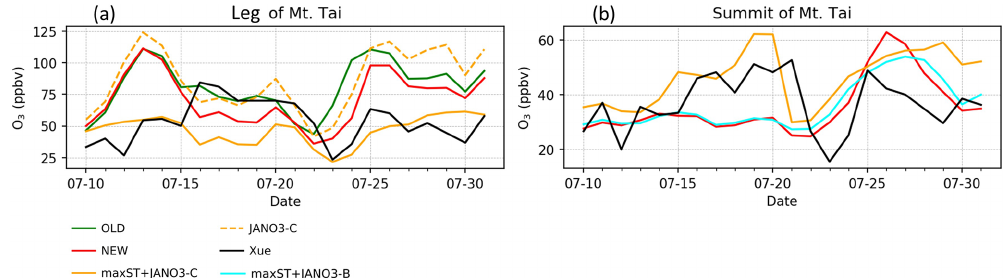
Figure 9. Daytime (05:00–18:00) average O 3 concentration during 9–31 July 2018 at the foot and summit of Mt Tai simulated in the model (coloured) and reproduced from Fig. 7 in Xue et al. (2022a) (black). In panel (b) , JANO3-B/C cases are overlapped with maxST + JANO3-B/C cases,